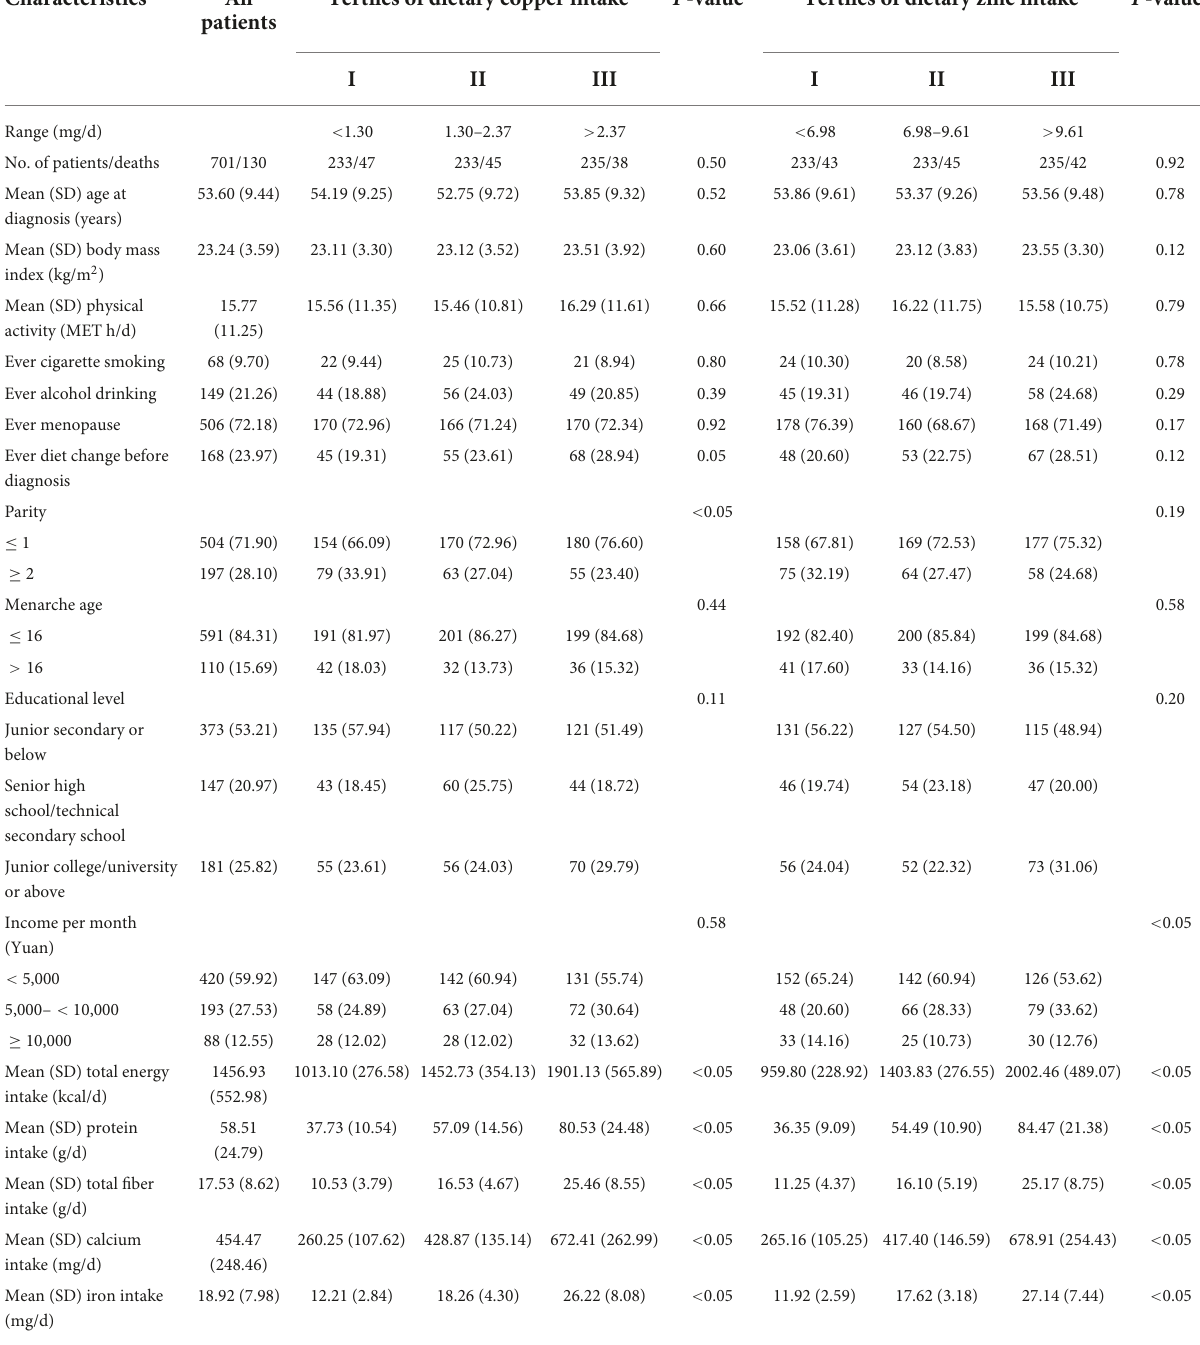
TABLE 1 Baseline characteristics of ovarian cancer patients by tertiles of dietary copper and zinc intake ( N = 701). Characteristics All Tertiles of dietary copper intake Tertiles of dietary zinc patients